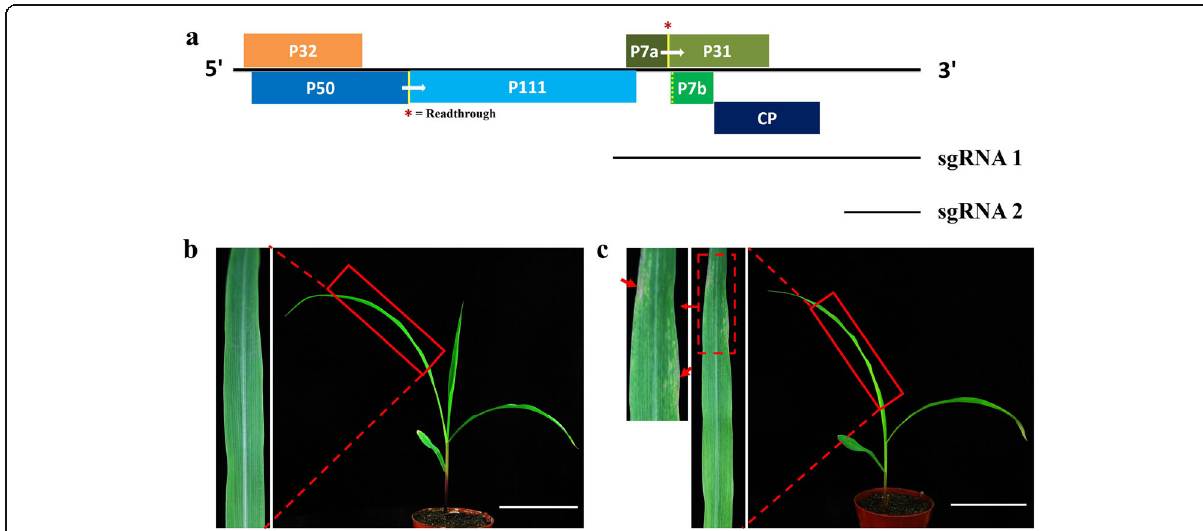
Fig. 1 Maize chlorotic mottle virus (MCMV) infection causes chlorosis and necrosis in maize leaves. a Genomic organization of MCMV. The heavy line indicates the genomic RNA and the thinner lines represent the subgenomic RNA1/2 (sgRNA1/2). Boxes indicate the coding regions and their open reading frames. The vertical lines (asterisks in red) indicate the leaky stop codons leading to translational readthrough. The dashed line (P7b) represents a non-AUG start codon. CP: coat protein. b , c Phenotypes in the first systemically infected maize leaves of mock-inoculated ( b ) or MCMV-inoculated ( c ) maize plants at 10 days post-inoculation (dpi). The red arrows indicate the necrotic regions. Bar, 10 cm